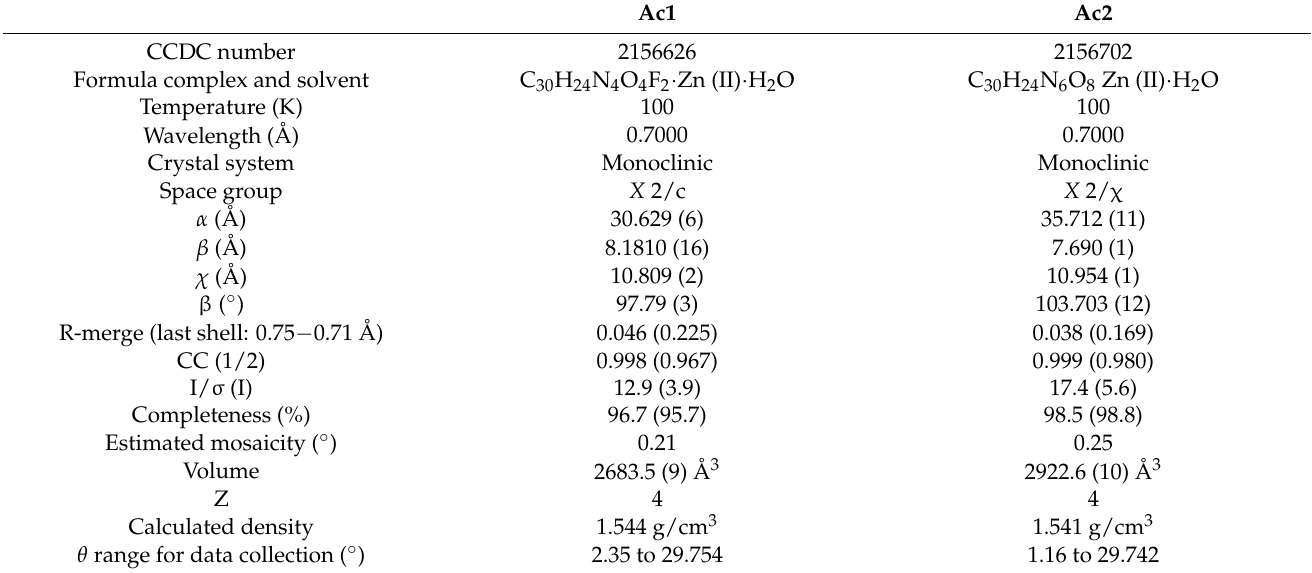
Table 3. Crystal data and structure refinement details for Ac1 and Ac2